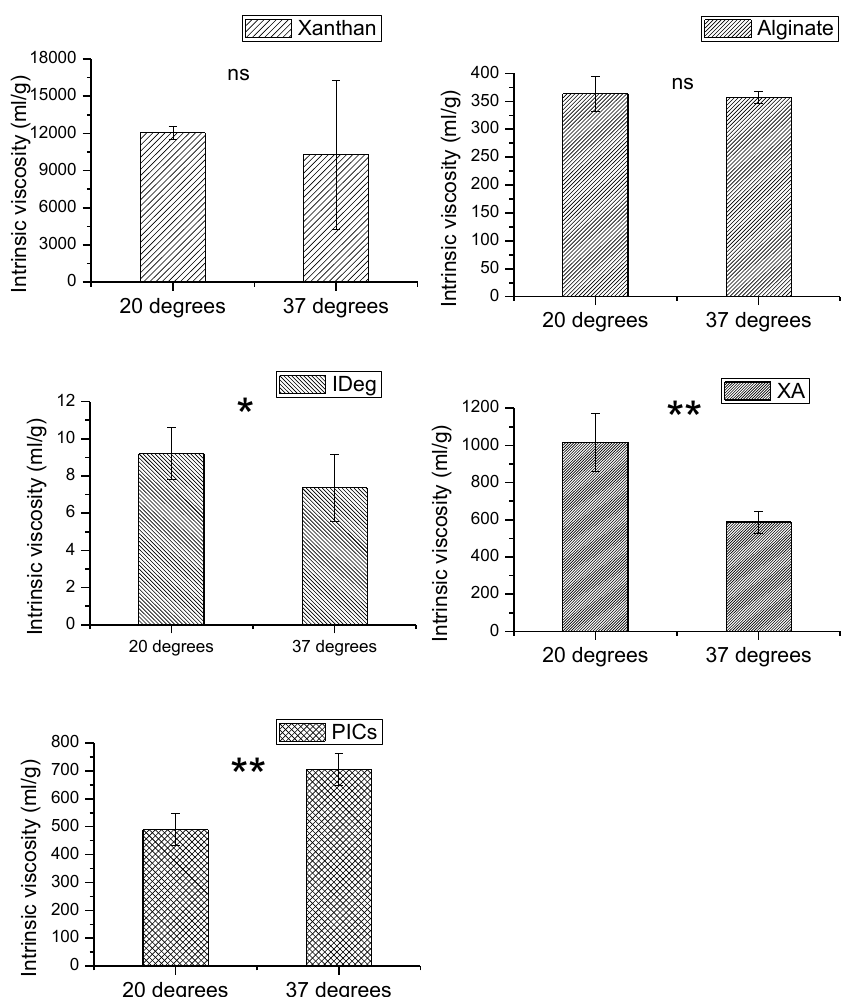
Figure 1. Intrinsic viscosity of xanthan (X), Alginate (A), degludec (IDeg), mixture of xanthan and Alginate (XA) and PIC measured at 20 °C and 37 °C. Data points represent SER, n = 3). ** (significant; P =< 10 −13 ), *(significant; P =< 0.05), ns = non-significant. Out of all the components, xanthan had the highest intrinsic viscosity which decreased with increase in temperature. This could be due to conformational transition between rigid to a disordered flexible state [31]. There is a high amount of error in 37 °C sample meaning that this trend is not statistically significant (p = 0.41). However, similar behavior in specific viscosity of xanthan was found in a related study [32]. We observed a critical overlap point [33] for xanthan at 1.75mg/mL sample concentration and above. Therefore, the experiment was limited to 1.75 mg/mL. Intrinsic viscosity of alginate was close to the literature values [34] with slight differences due to the type of salt and buffer molarity. Increase in temperature did not result in any change in intrinsic viscosity of alginate. Alginate exhibited higher intrinsic viscosity measurement compared to degludec; however, it was less viscous than xanthan on its own. IDeg had the lowest intrinsic viscosity of all the components. Unlike the two polysaccharides, significant decrease in intrinsic viscosity of IDeg was observed with an increase in temperature (p =